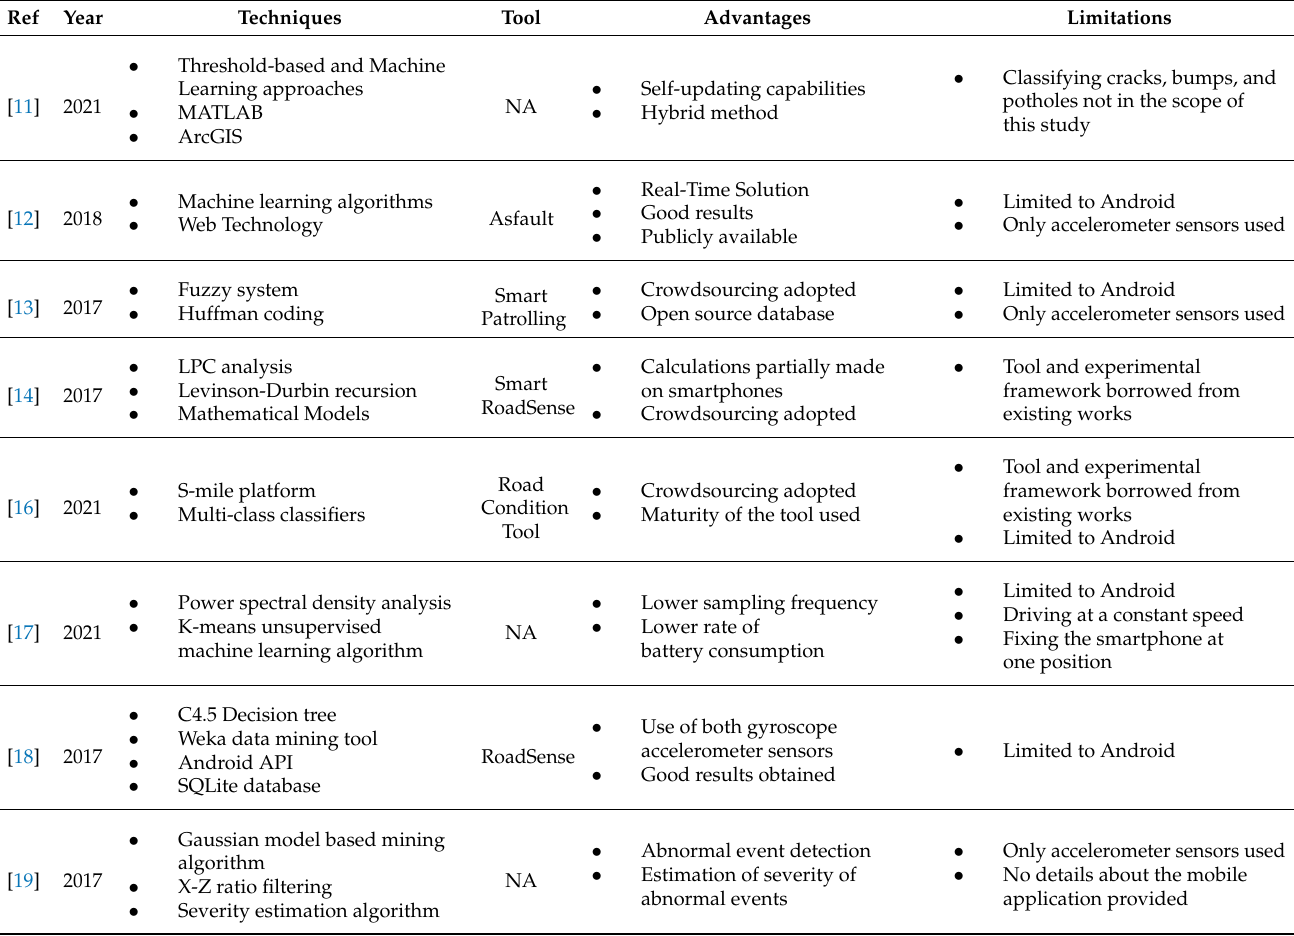
Table 1. Summary of related